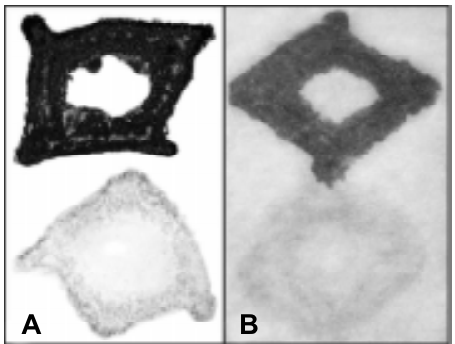
Fig. 1. Detection of Alfalfa mosaic virus (AMV) by TBIA in infected faba bean tissue blotted on nitrocellulose mem- brane (A) and on HP non-glossy plotter paper (B). In all duplicate stem blots, the healthy tissue is at the bottom of the picture and the AMV-infected tissue is at the top.